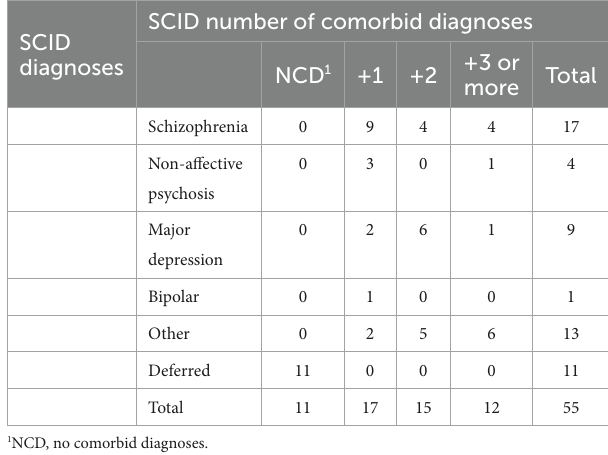
TABLE 2 SCID diagnoses and number of comorbid diagnoses.